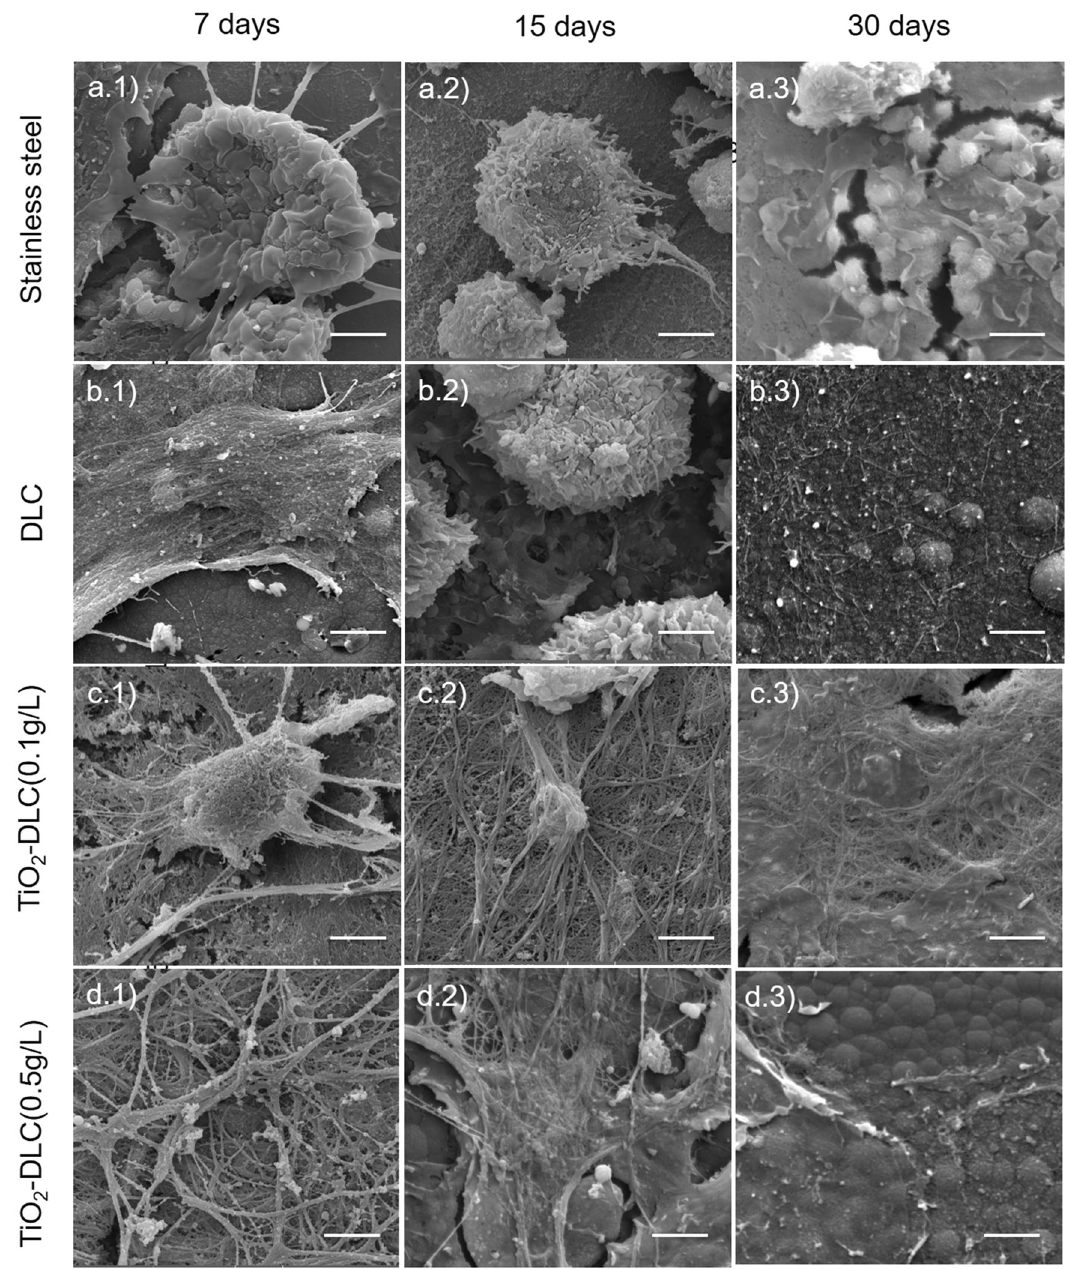
Fig. 5 Scanning electron microscopy images of peritoneal macrophages from ( a ) stainless-steel, ( b ) DLC, ( c ) TiO 2 -DLC (0.1 g/L), and ( d ) TiO 2 - DLC (0.5 g/L) groups at (1) 7, (2) 15, and (3) 30 days. Each bar represents 2 µm. Magni fi cation 20.0